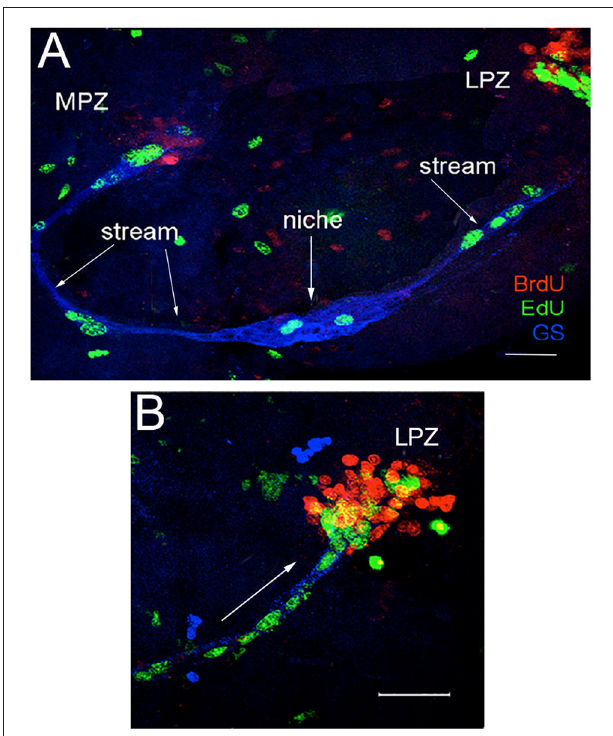
FIGURE 3 | Double-nucleoside labeling demonstrates that the niche cells are not self-renewing. Crayfish were incubated for 24h in BrdU (red), then maintained in pond water for 7 days. Six hours before sacrifice, they were treated with EdU (green). Brains also were labeled immunocytochemically for glutamine synthetase (blue) to reveal the niche and streams. (A) BrdU + cells were found only in the proliferation zones (MPZ and LPZ), not in the niche. Only EdU labels S-phase cells in the niche, showing that niche cells do not retain BrdU, and thus that divisions are not self-renewing. These labeling patterns also demonstrate that migration is unidirectional, away from the niche. (B) Higher magnification image of the LPZ. Arrow in B indicates the direction of neural precursor cell migration. Scale bars: (A) , 100 µ m; (B) , 50 µ m. Adapted from Benton et al.